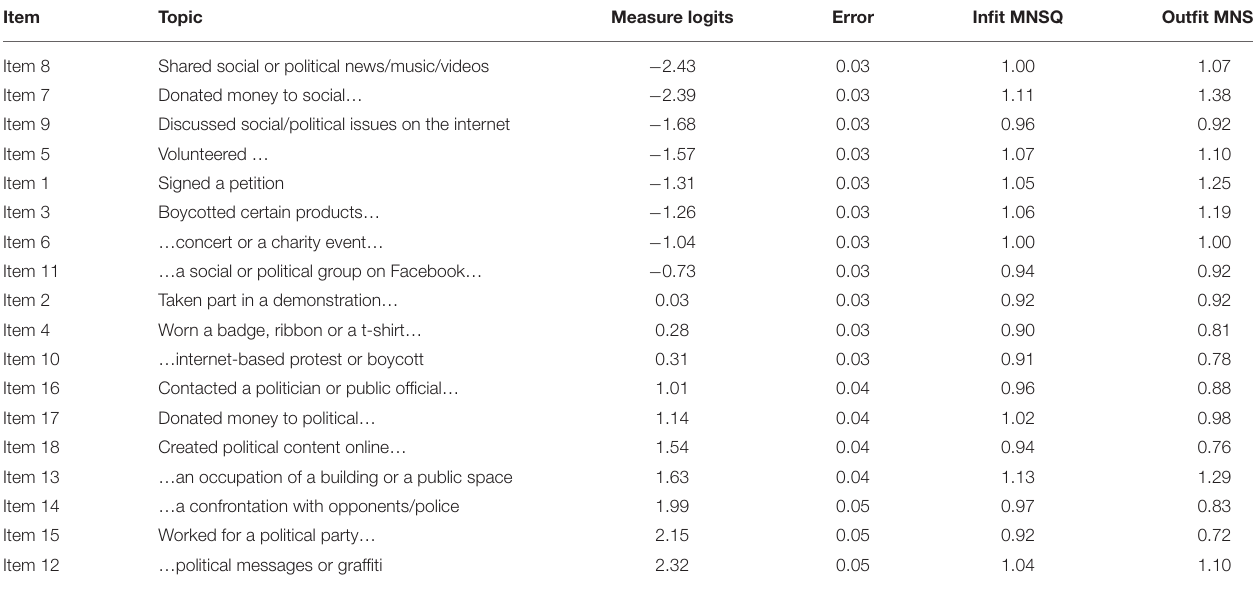
TABLE 5 | Item statistics (organized by item difficulty).